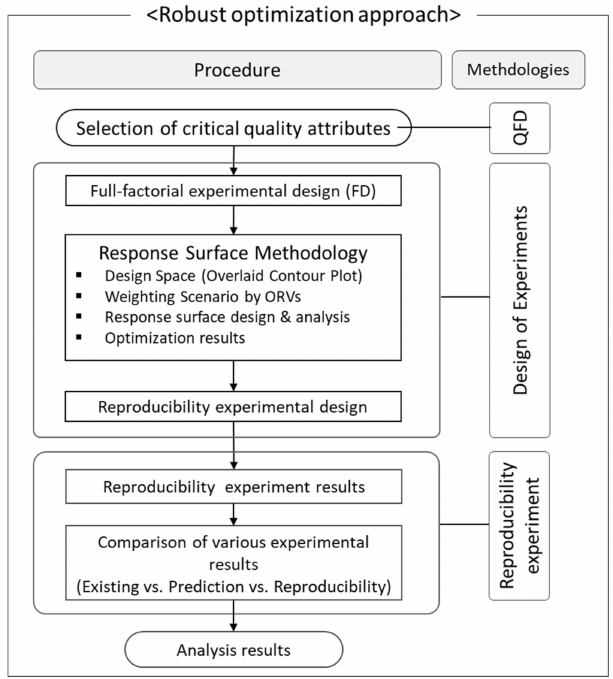
Figure 3. Overview of Robust Optimization